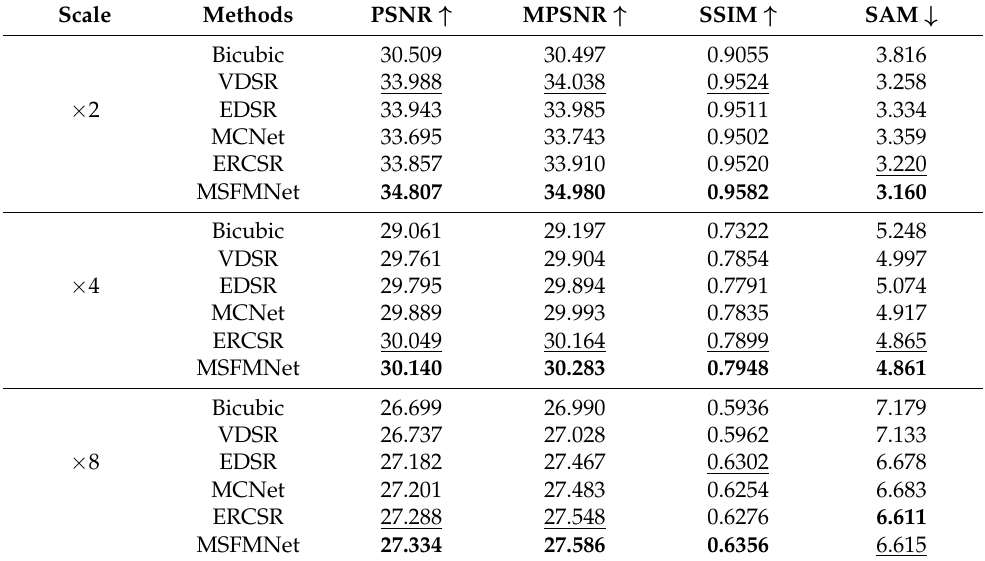
Table 3. Quantitative evaluation on the PaviaU dataset of state-of-the-art hyperspectral image sr algorithms: average psnr/mpsnr/ssim/sam for scale factors 2, 4, and 8.